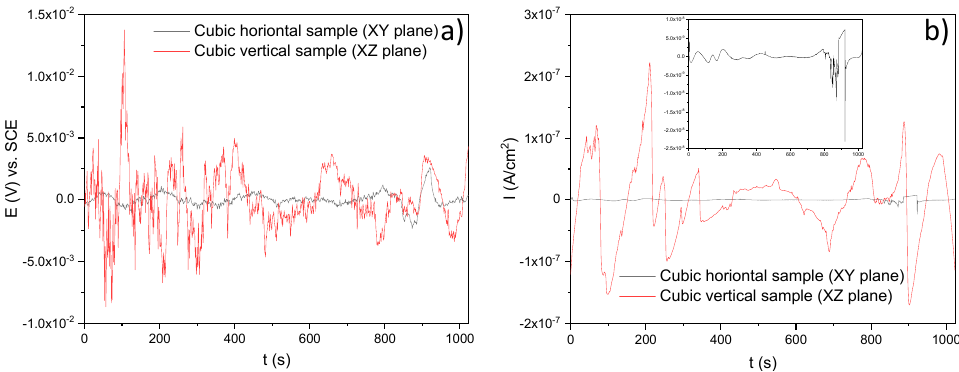
Figure 8. Time series in potential and current of the SLMed 316L SS in 3.5 wt. % NaCl : ( a ) potential versus time and ( b ) current versus time.